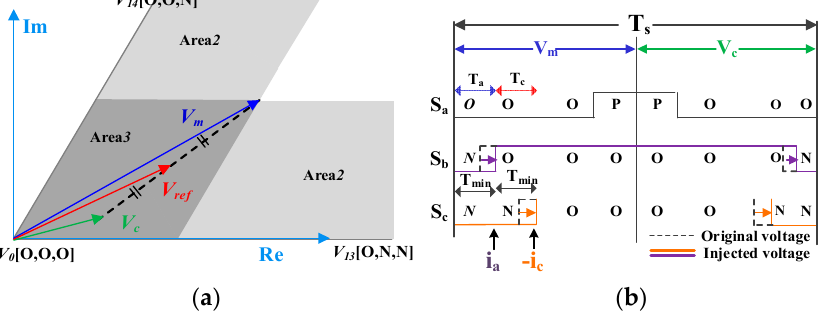
Figure 11. Minimum voltage injection method. ( a ) Voltage injection method in Area 3; ( b ) PWM switching patterns.